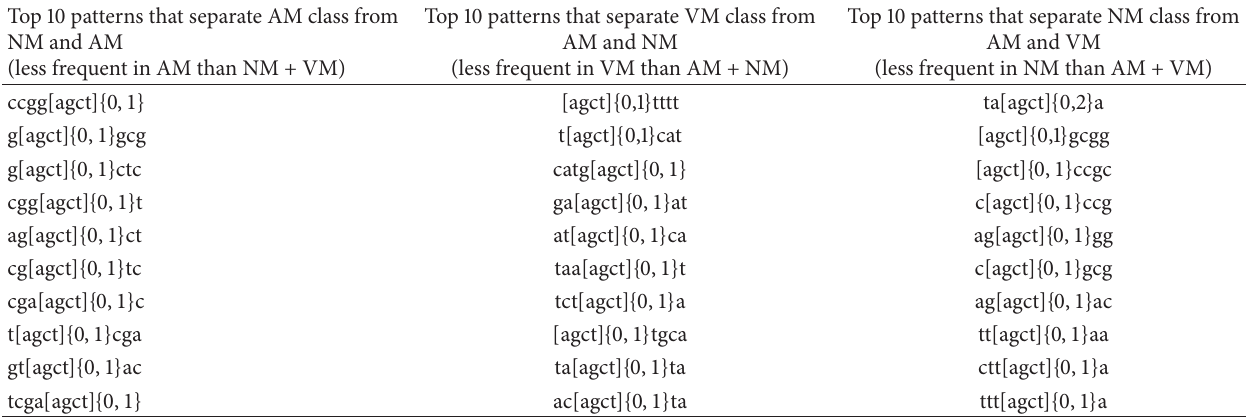
Table 1: Table of discriminatory